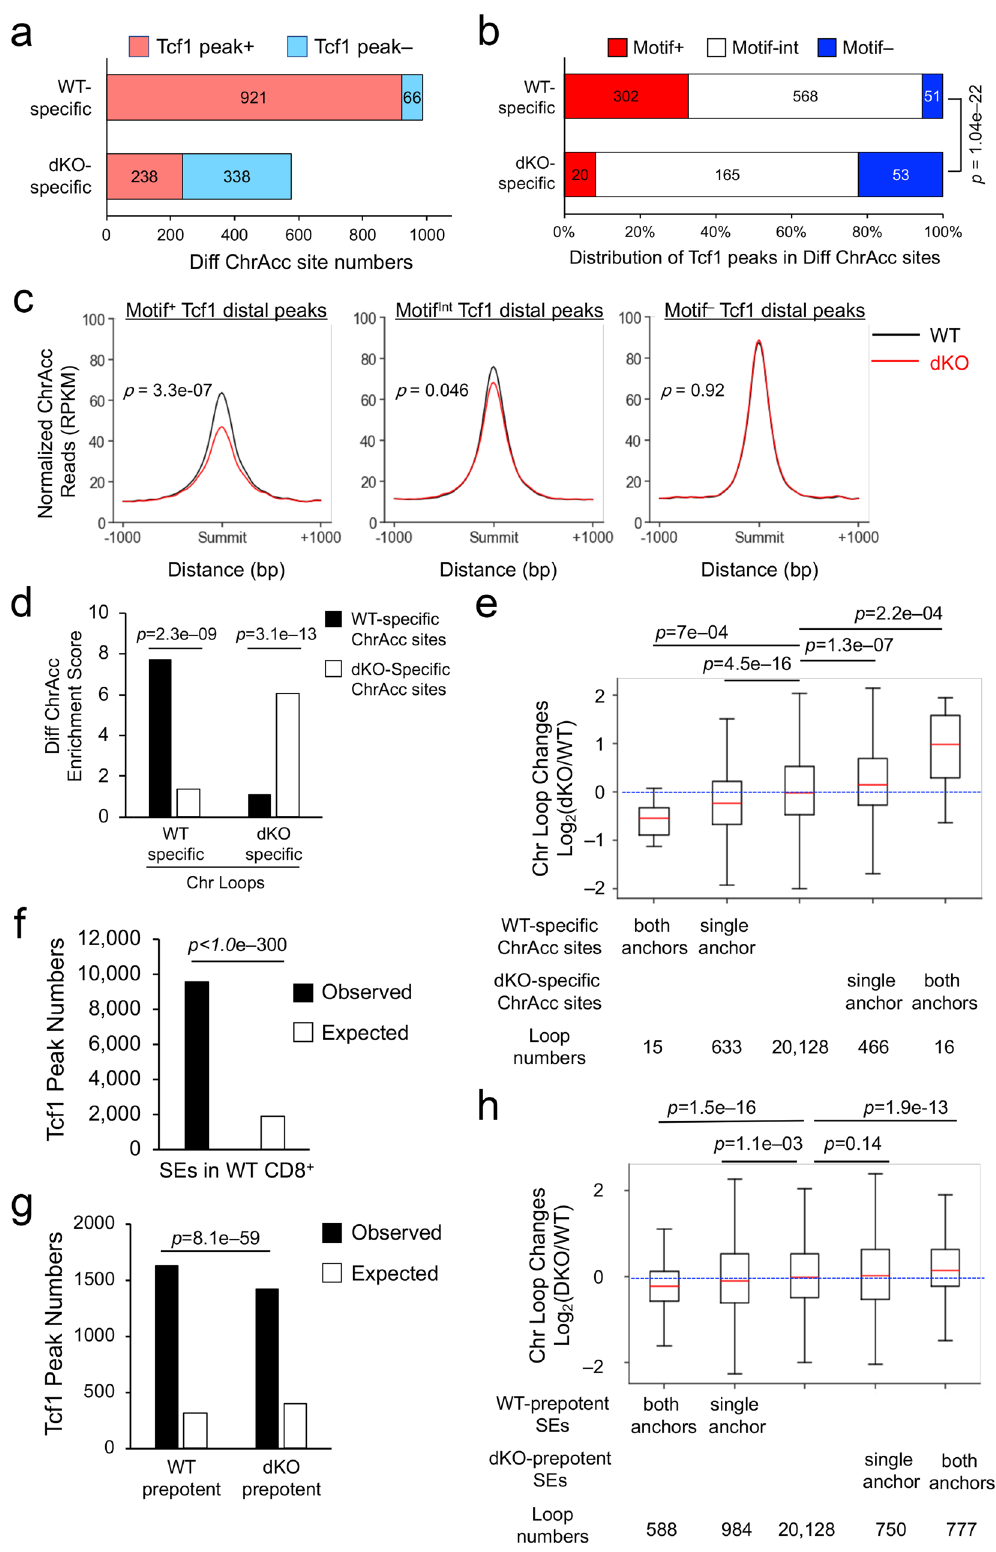
seven cell types, which included pan-T cells (including naïve CD8 + , conventional naïve CD4 + , Treg, and γδ -T cells), B cells, pan-NK subsets), conventional DCs (cDCs including CD4 + and CD8 + and Ly6C − subsets), and bone marrow-derived granulocytes (Fig.